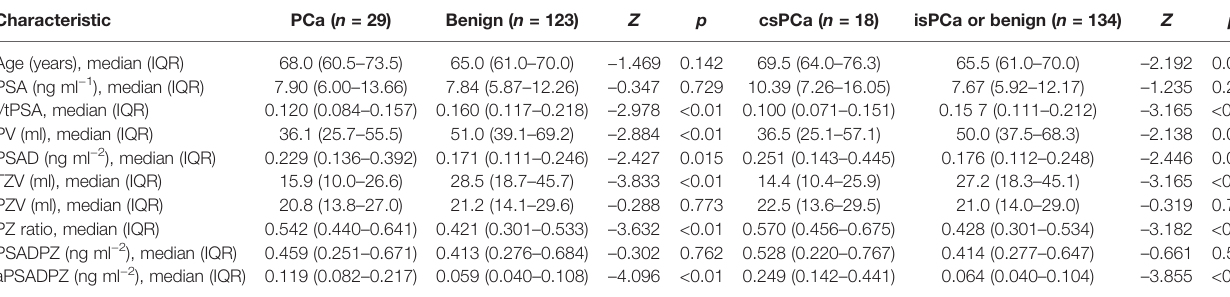
TABLE 1 | Patient demographics and the correlation with biopsy